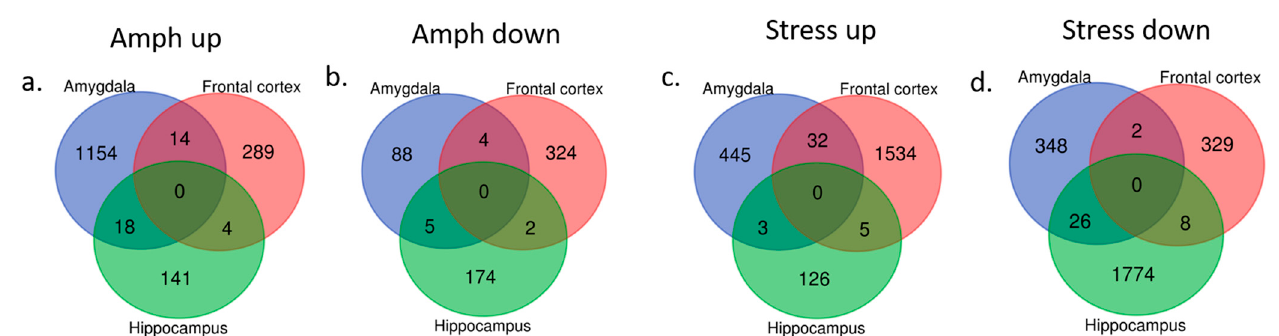
Figure 3. Differentially expressed genes (up- and downregulated) in three analyzed brain regions (amygdala, frontal cortex and hippocampus) in amphetamine-exposed ( a , b , respectively) and stress-exposed rats ( c , d , respectively) as compared to the control group.